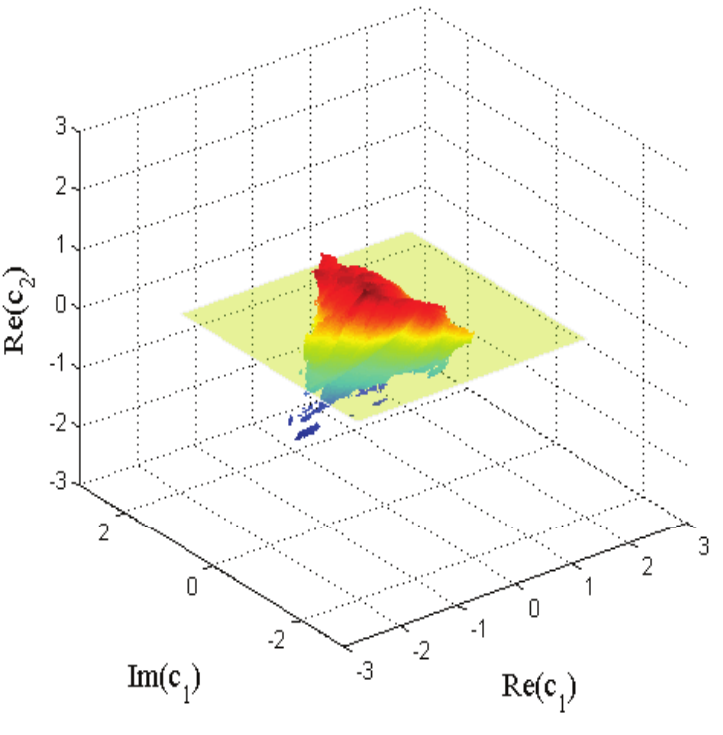
Figure 3. Spatial-Connected Loci ( M ( P ) without Disconnected Loci) with Im ( c 2 ) = 0.3.